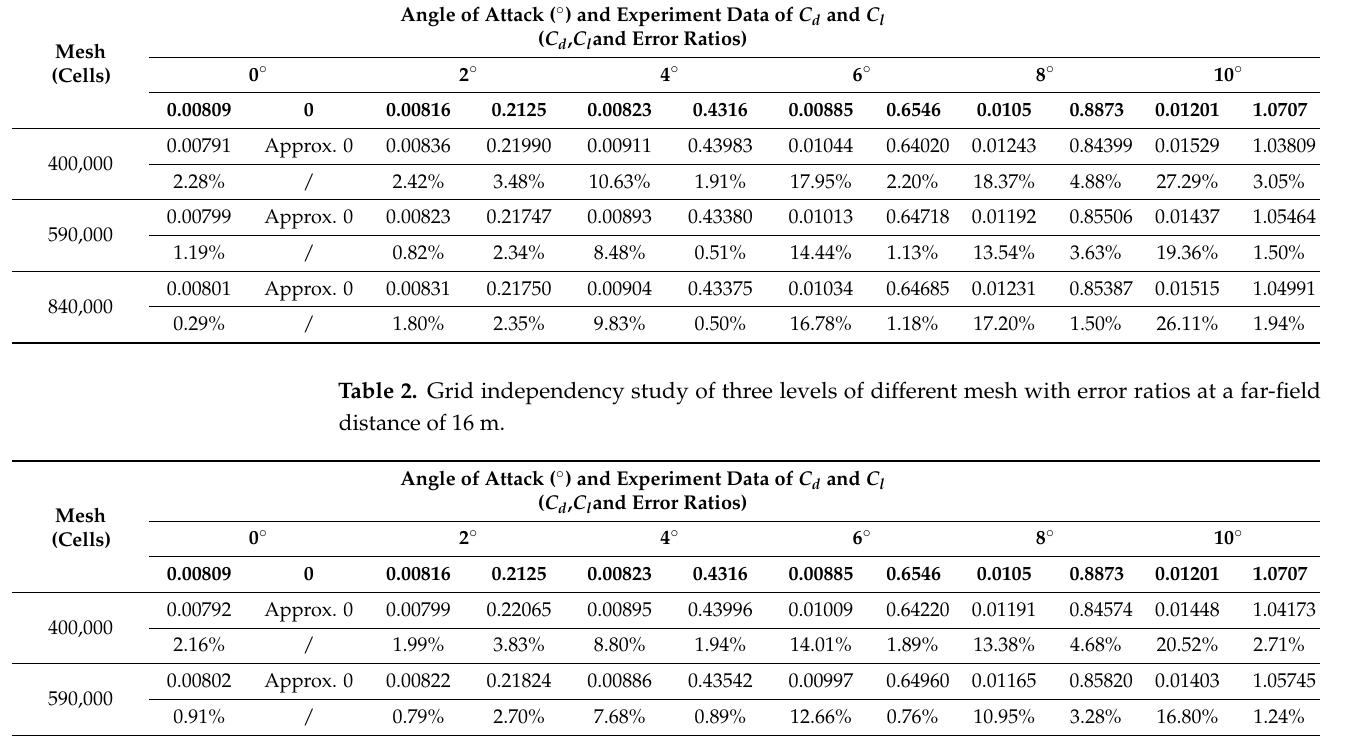
Table 1. Grid independency study of three levels of different mesh with error ratios at a far-field distance of 12 m.